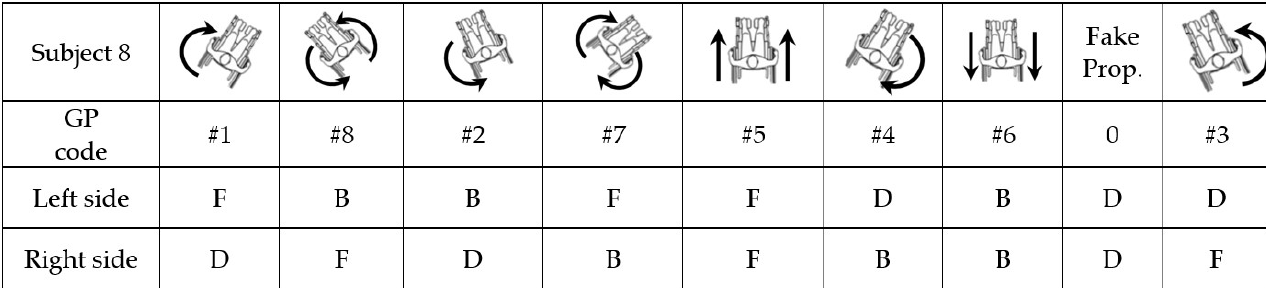
Figure 11. Example of choreography performed by a subject. Left and right classifiers only recognize three gestures for each one, and the rest of choreography are gestures composed of the gestures of both arms. FPGs are recognized as dance gesture. Dance (D), forward (F), and backward (B).